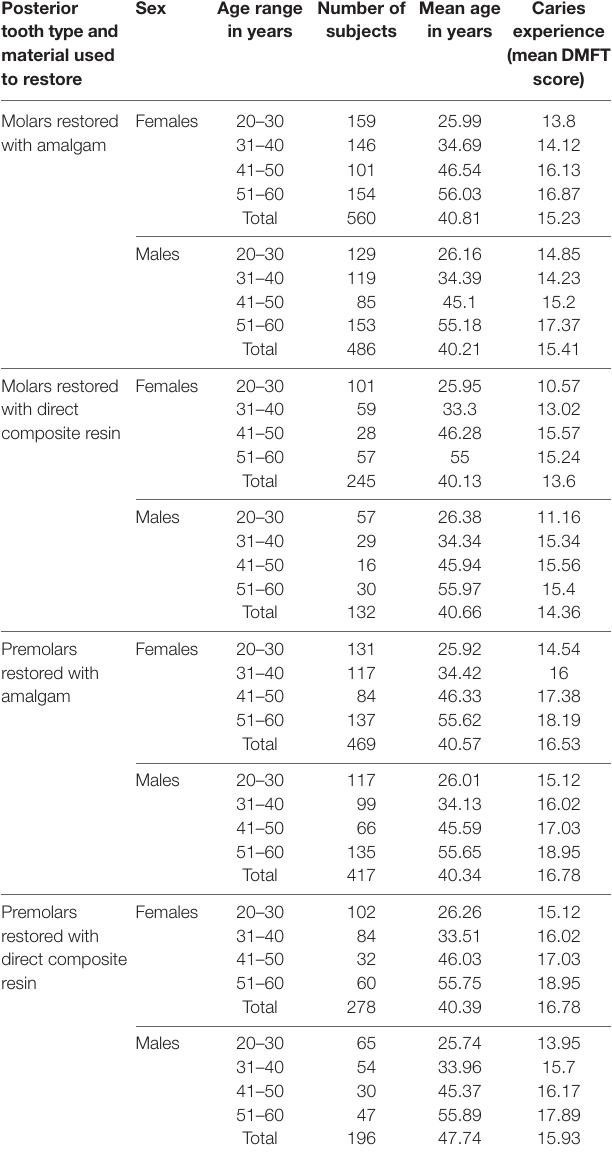
Table 1 | Age, sex, and caries experience of the study population.